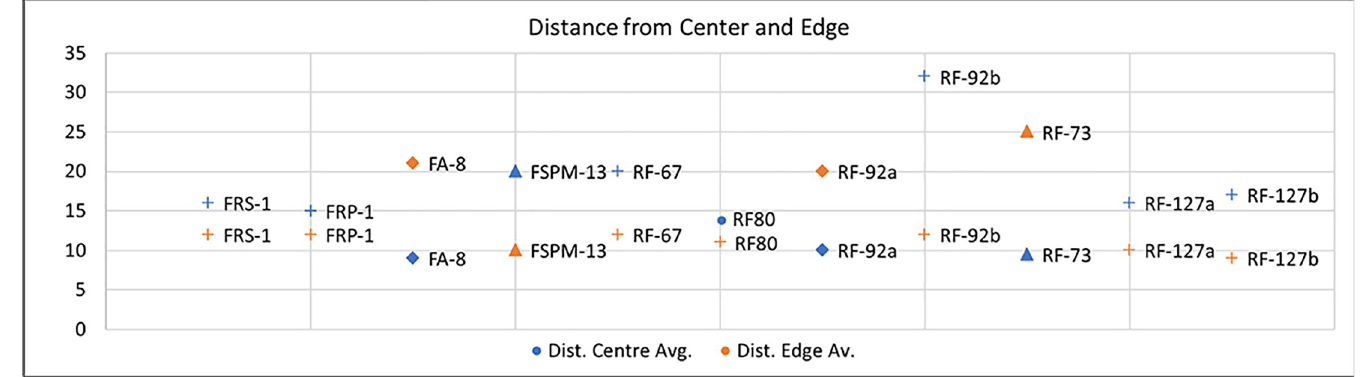
Fig 31. Comparison between the mean distances from the centre and the edge of the tool observed on the experimental and archaeological